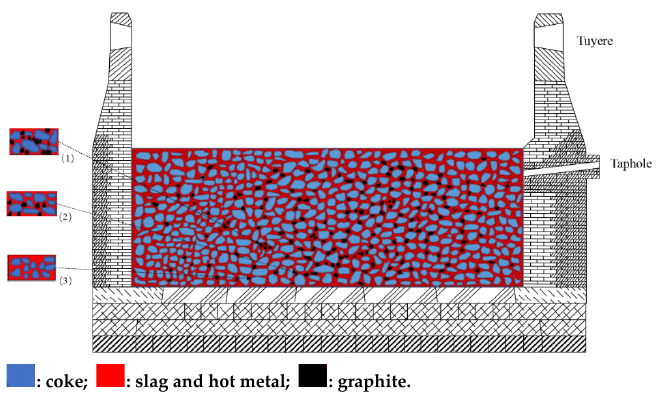
Figure 1. Diagram of precipitation and disappearance of graphite in the BF hot metal. (1) : Graphite is enriched in the deadman. (2) : Graphite is precipitated in hot metal. (3) : Graphite is dissolved in hot metal.